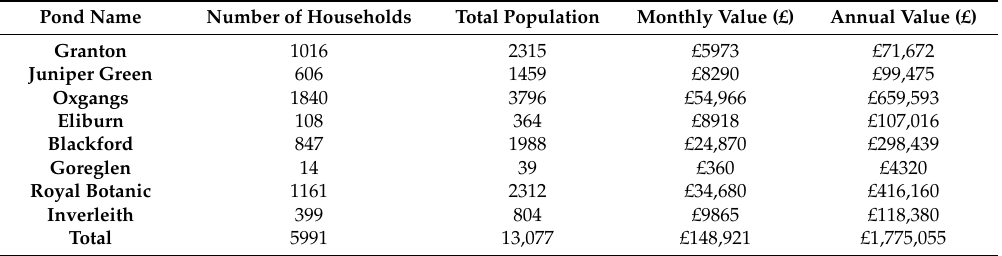
Table 3. Monthly and annual values (Willingness to Pay) for habitat benefits according to the number of residents in a household [20]. Where: Number of residents in households (total n = 13,077). Total value is calculated using the total benefits per person multiplied by the total population living within a 500 m radius of their local pond (Table 1).